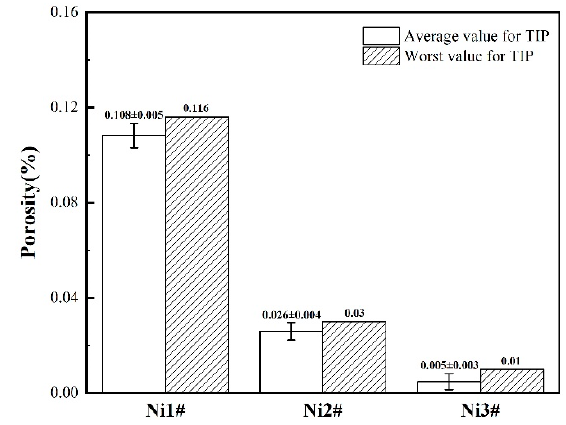
Figure 4. Initial TIP values of the as-HIPed P/M FGH97 superalloys.